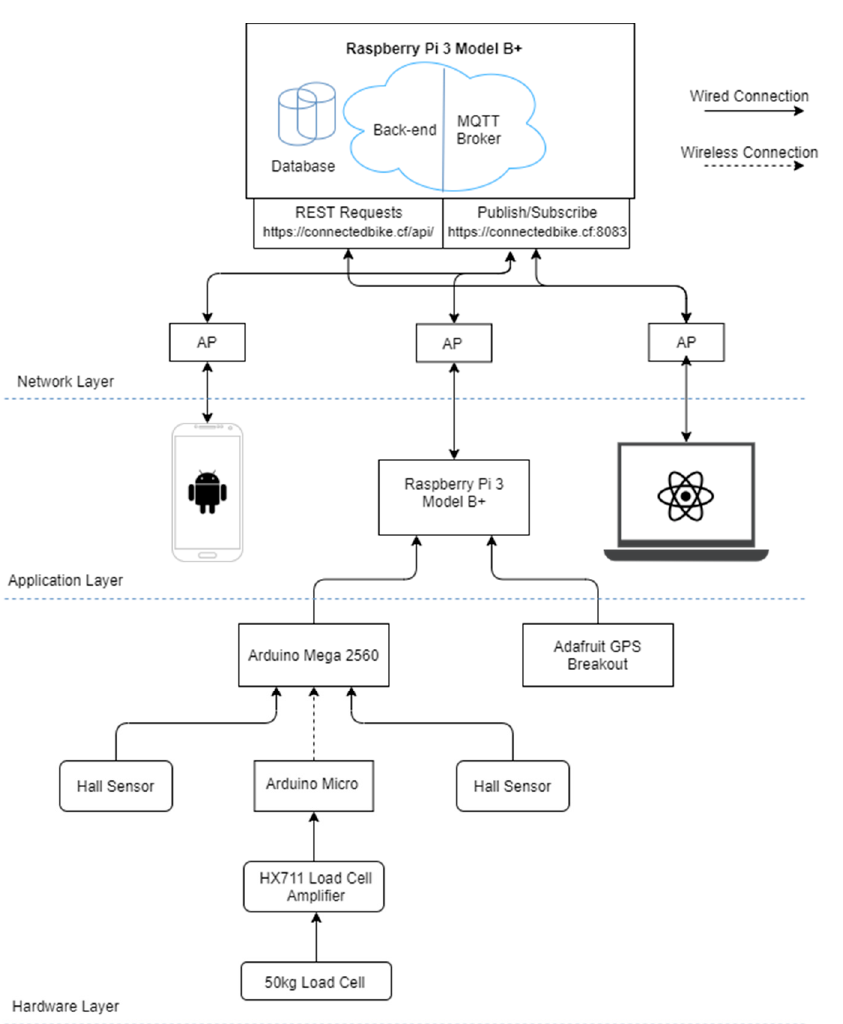
Figure 1. Connected Bike system architecture.